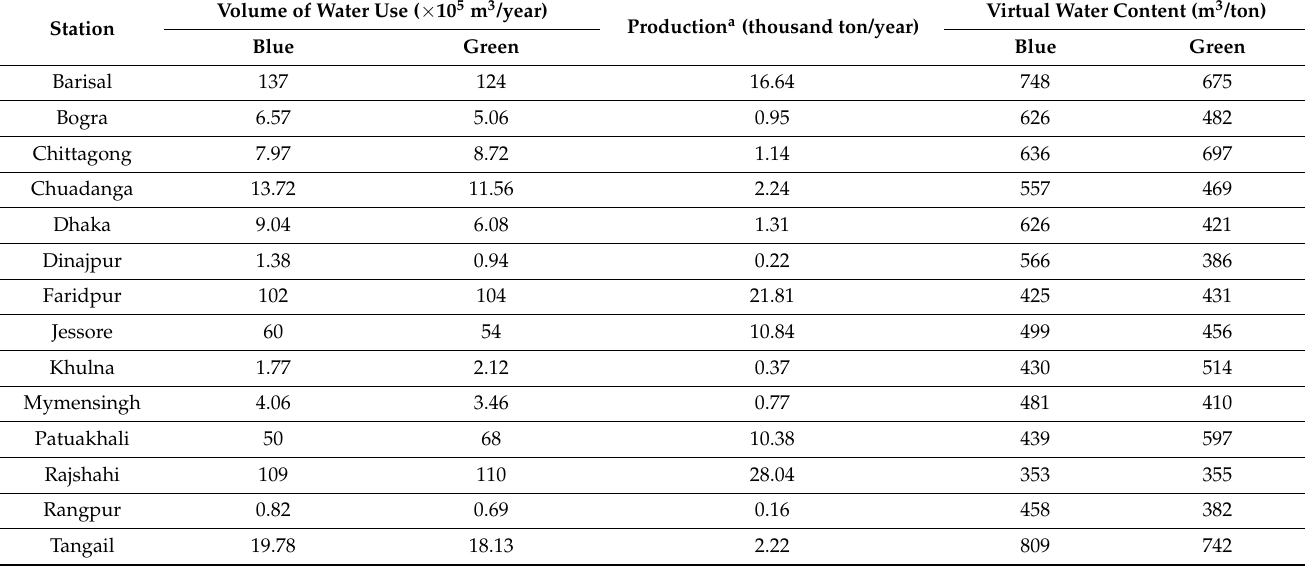
Table A6. Blue water footprint and green water footprint of pulse in